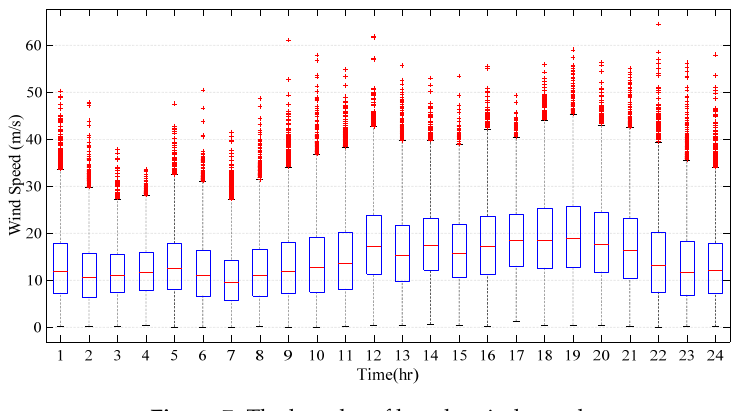
Figure 6. The boxplot of hourly electricity price.